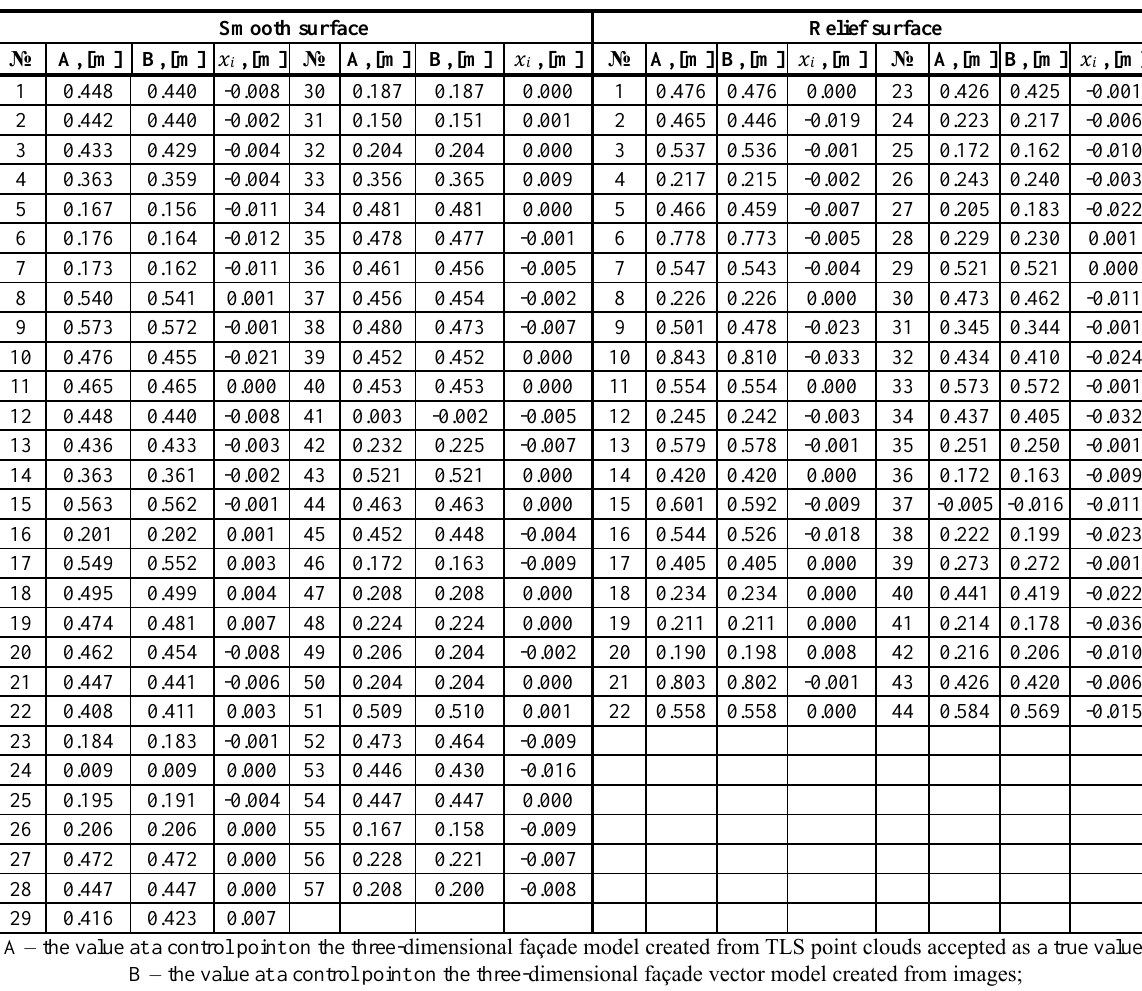
Table 3. Discrepancies of digital models